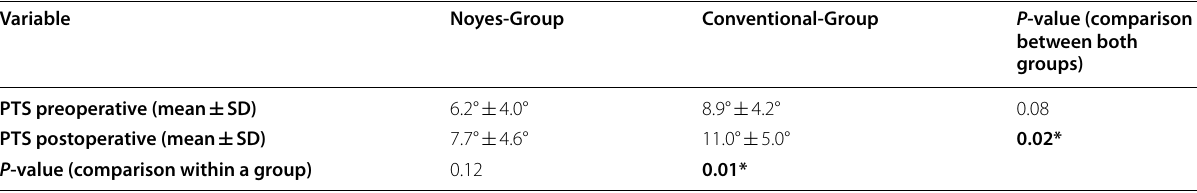
Preoperative and postoperative mean values of the posterior tibial slope (PTS) for the Noyes- and Conventional-Group respectively. P -values are displayed for comparison of the mean PTS from the pre- to postoperative visit within a group (last row) as well as for comparison of the PTS between the groups (last column). Statistically significant values are marked by asterisks